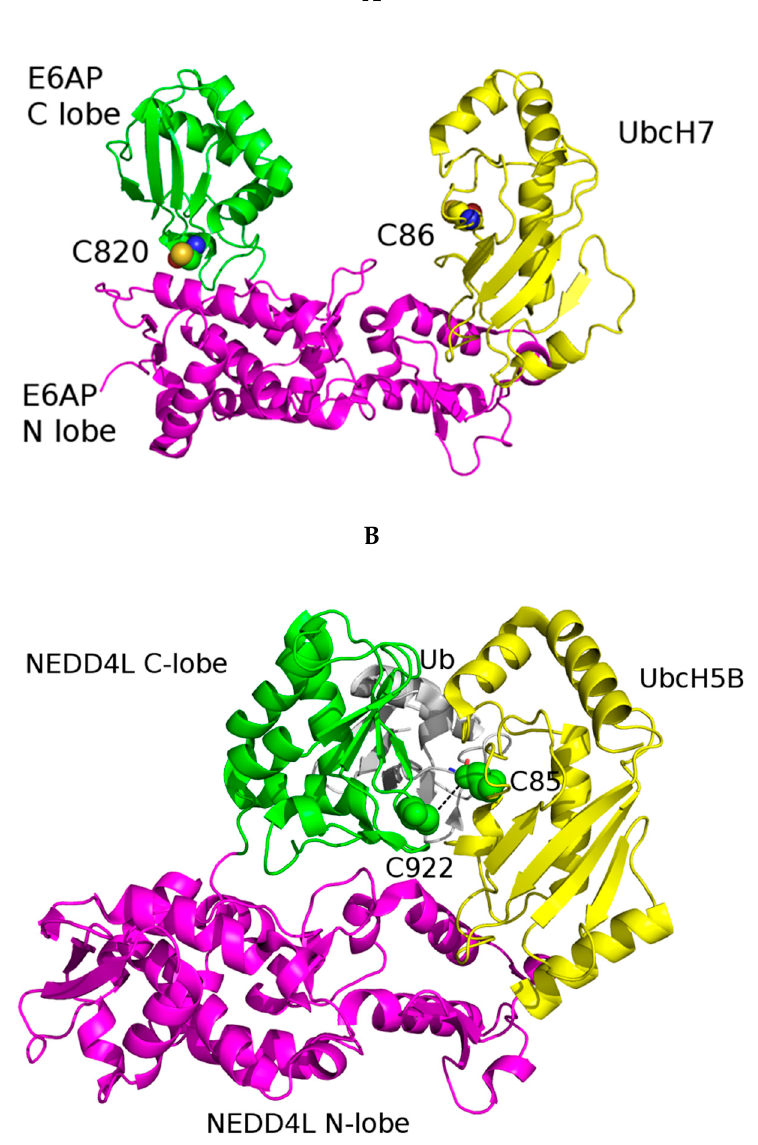
Figure 3. ( A ). HECT domain of UBE3A/E6AP in complex with the E2 UbcH7 (PDB code: 1C4Z). UbcH7 is colored yellow and the C and N lobes of the HECT domain are colored green and magenta, respectively. The catalytic cysteine residues of UBE3A and UbcH7 are represented as spheres and colored by atom type (N, blue; O, red; S, yellow; C, green and yellow, like the respective ribbon color). ( B ). HECT domain of NEDD4L in complex with the E2 UbcH5B (PDB code: 3JW0). Color coding: UbcH5B, yellow; C and N lobes of the NEDD4L HECT domain, green and magenta, respectively; ubiquitin (Ub), grey. The catalytic cysteine residues of NEDD4L and UbcH5B are shown as spheres and colored green.